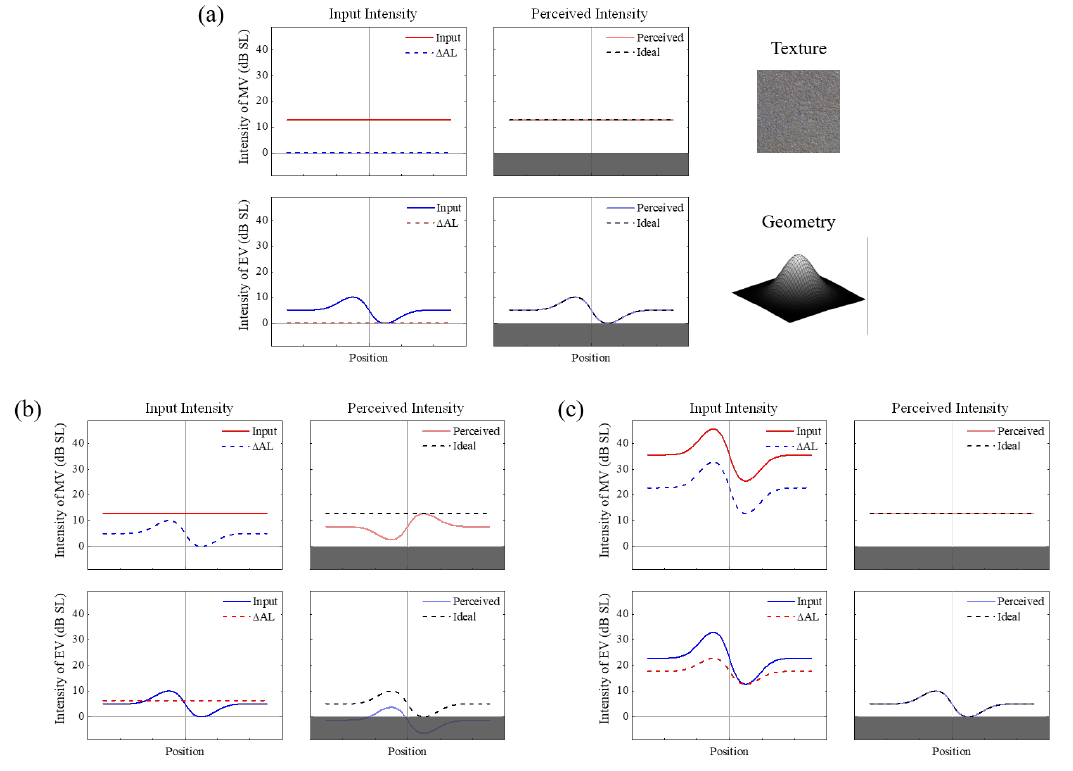
Figure 4. Input and perceived intensity when both geometry and texture information are provided: ( a ) ideal case, ( b ) without the algorithm, and ( c ) with the